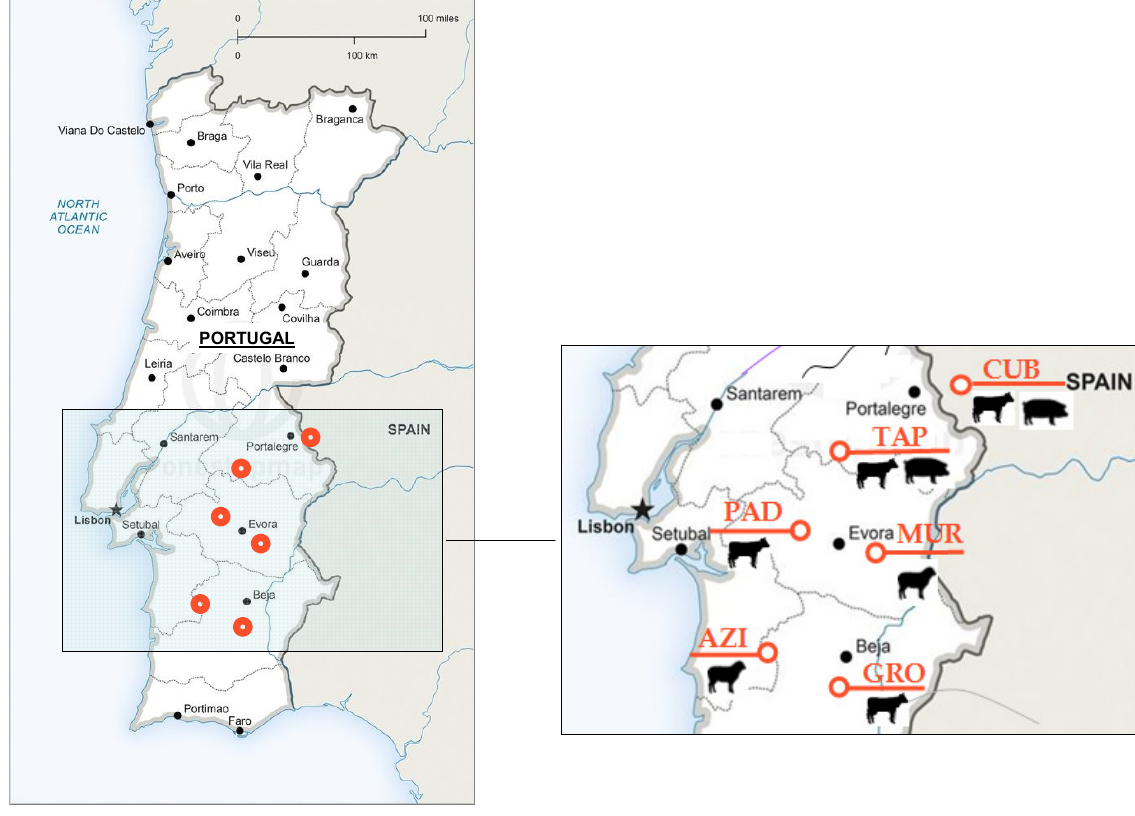
Figure 2. Location of the six experimental fields in the Alentejo, southern Portugal. Table 1. Main characteristics of the six experimental fields used in this